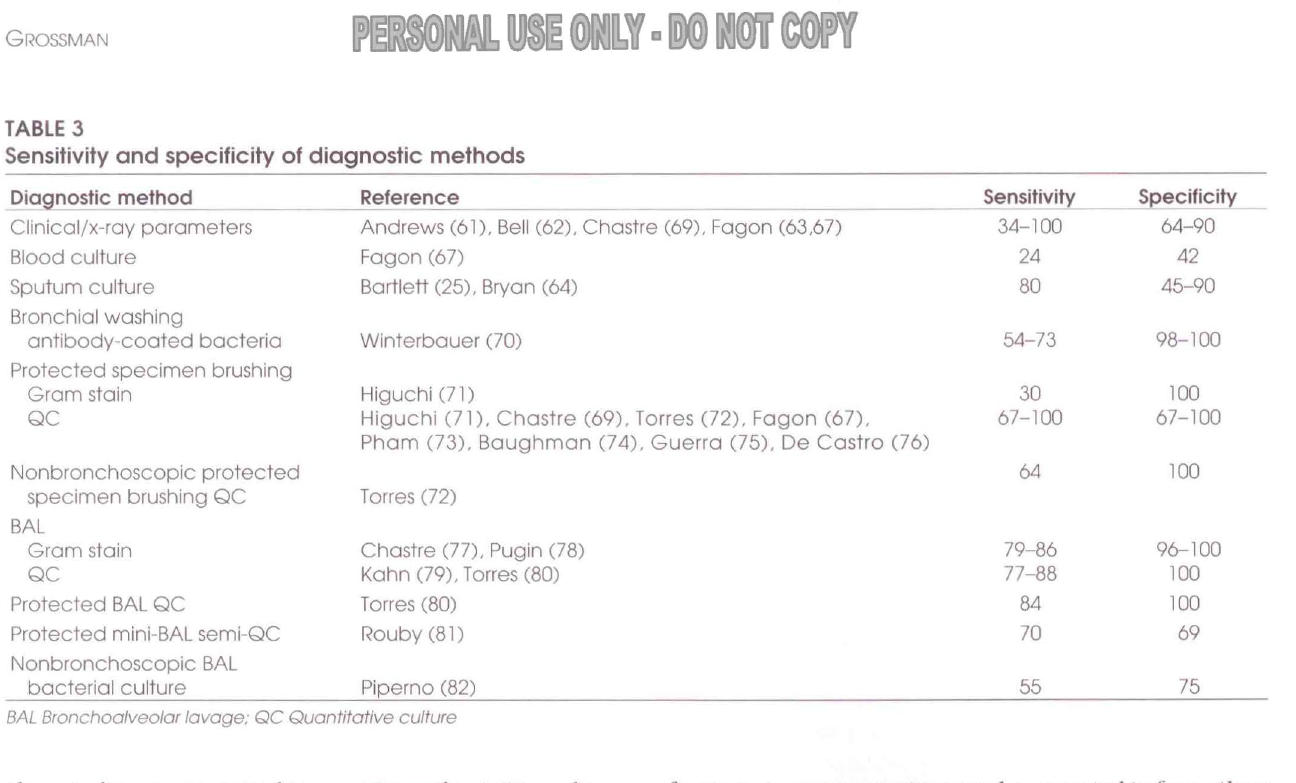
Reference ------ Diagnostic